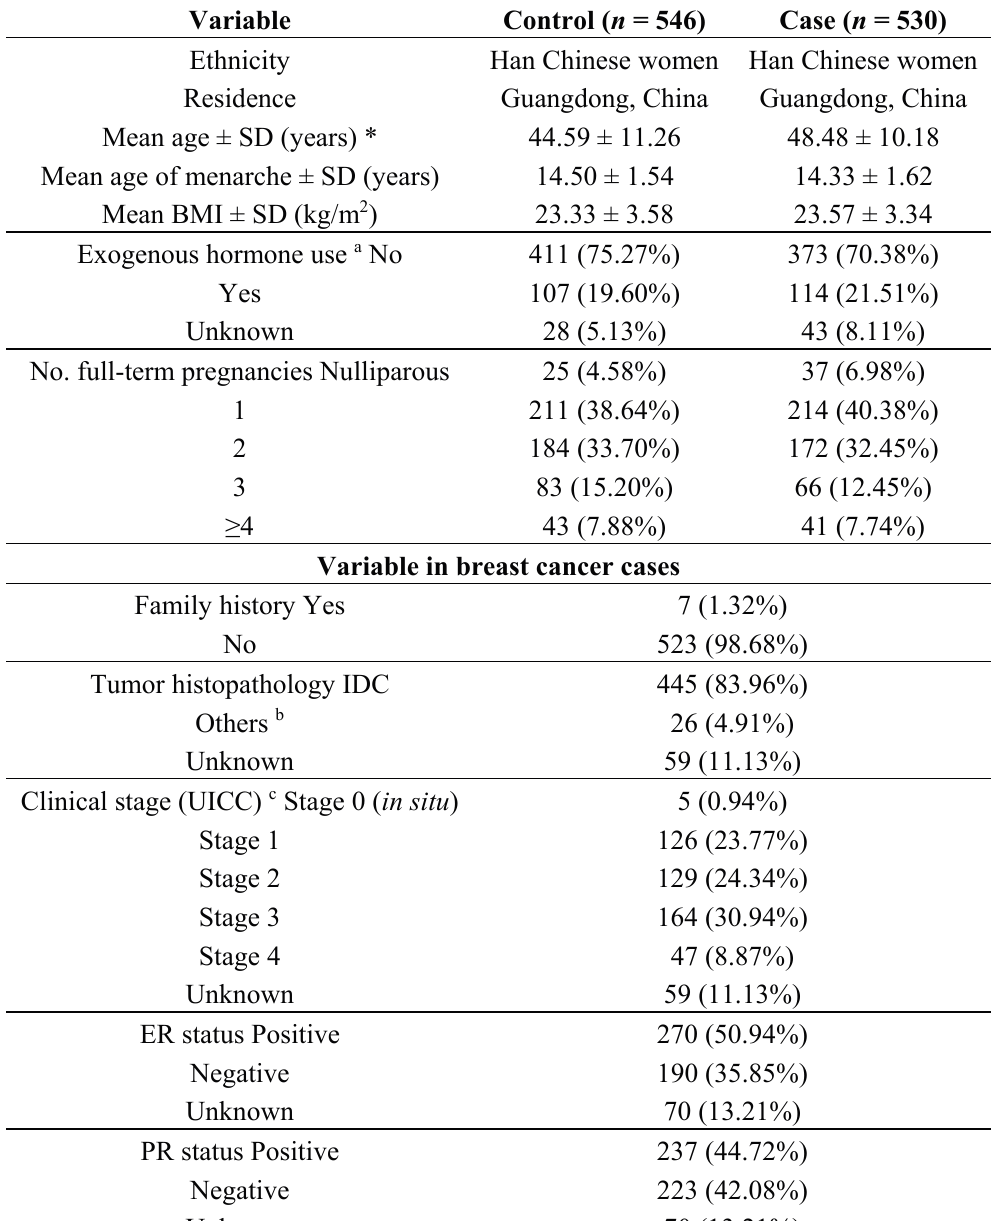
Table 1. Baseline characteristics of the study